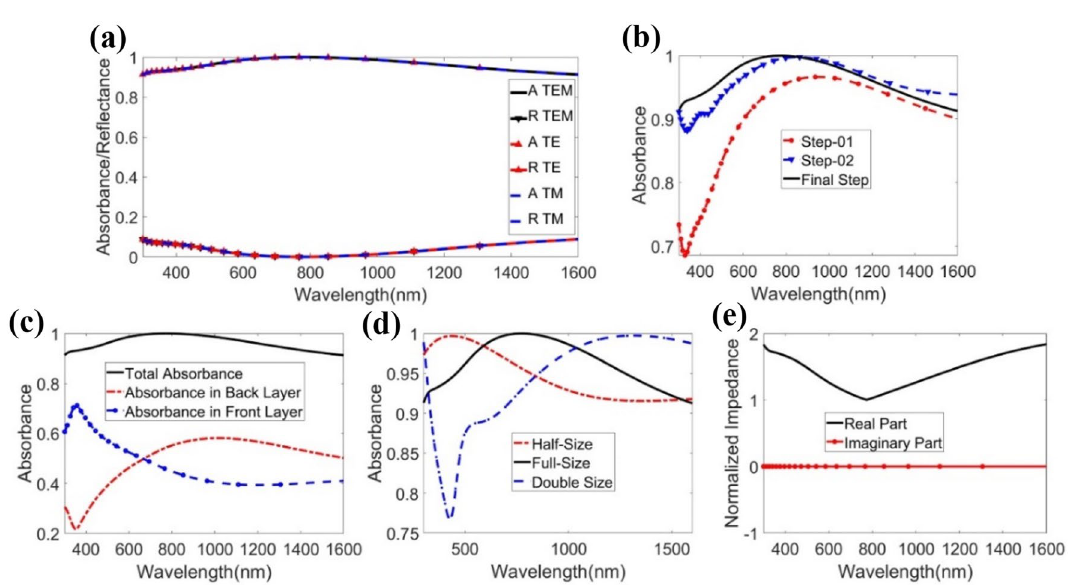
Figure 2. Here, ( a ) absorption in three EM mode TEM, TE, and TM, from 300 to 1600 nm, ( b ) step by step design evaluation absorption, ( c ) absorption in back and front layer, ( d ) absorbance in half and double of the size, ( e ) real and imaginary parts of